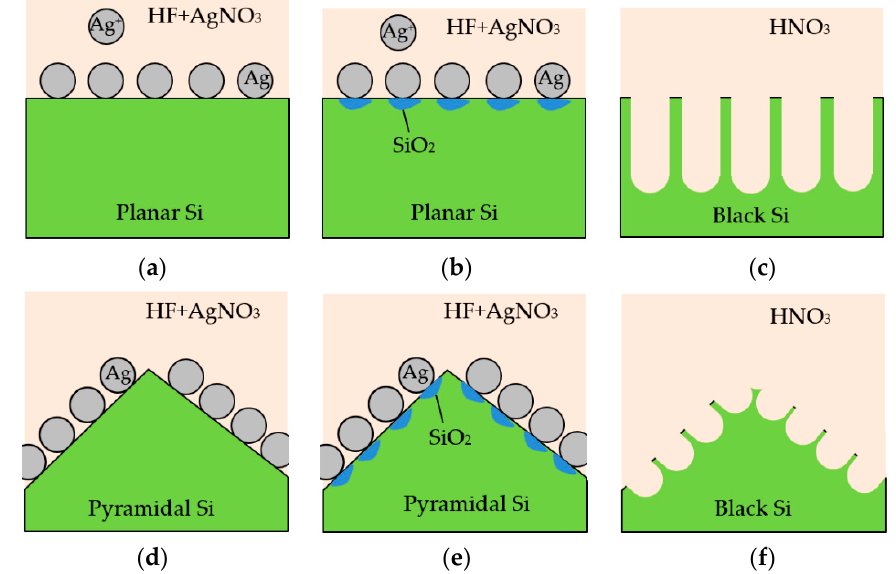
Figure 1. Schematic diagram of the metal-assisted chemical etching (MACE) process: ( a ) silver particles on the planar wafer; ( b ) local oxidation of Si on the surface; ( c ) sharp and deep needles formed after removing Ag particles by HNO 3 ; ( d ) silver particles on the pyramidal surface of an alkaline-etched silicon wafer; ( e ) silicon oxidation on the pyramidal surface; and ( f ) small-size needles formed on the pyramidal surface.